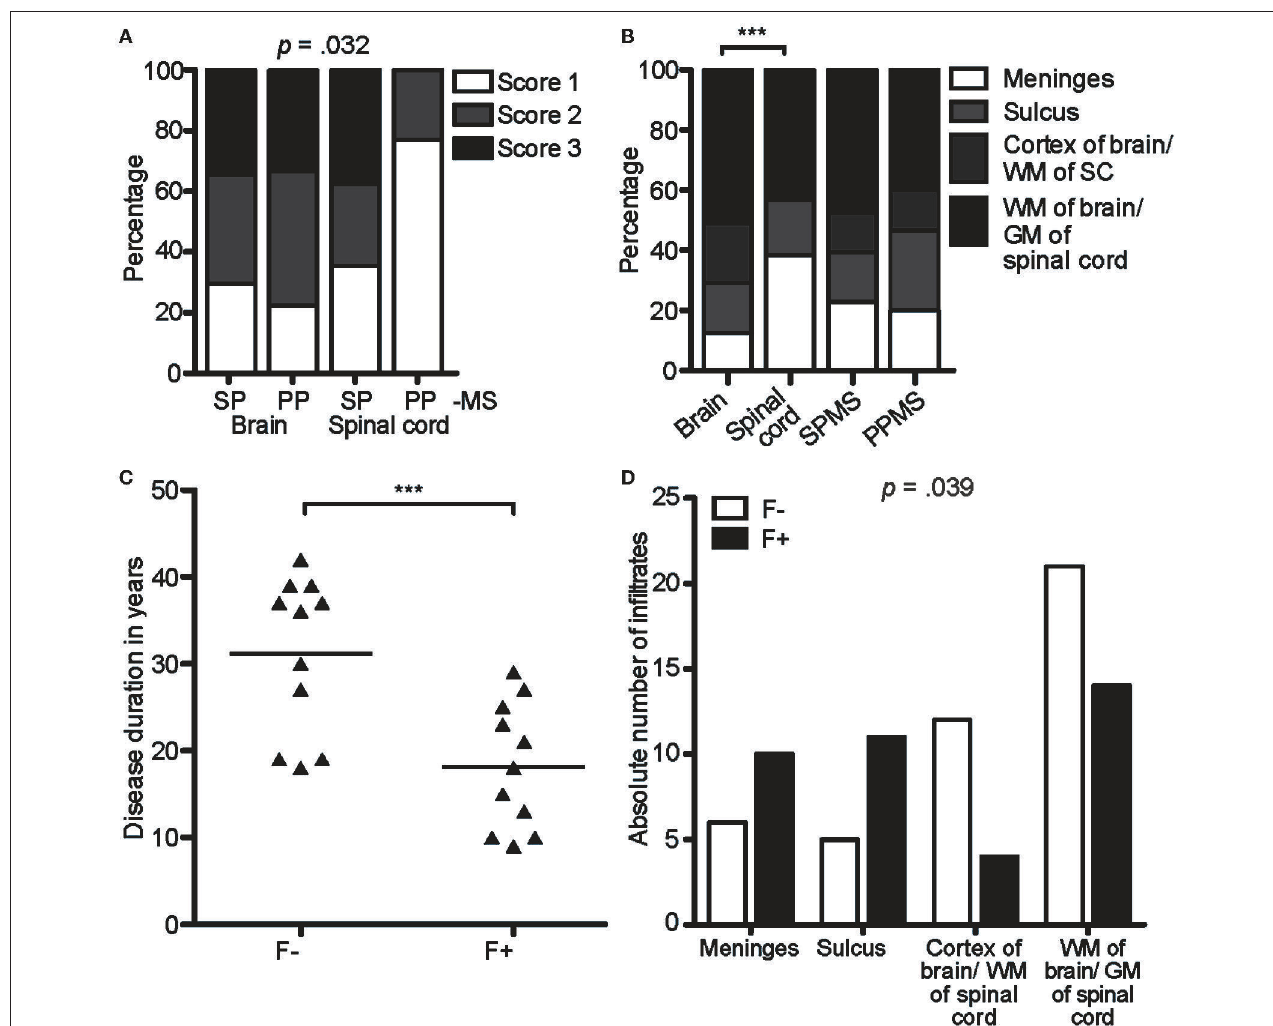
FIGURE 2 | CXCR5-rich lymphoid aggregates are most prominent within meninges of SPMS patients. (A) Percentage of score infiltration in SPMS and PPMS in CAL brain and spinal cord. SPMS brain infiltrates, n = 78; SPMS spinal cord, n = 48; PPMS brain, n = 9; PPMS spinal cord, n = 13. Chi-square test, X 2 (6) = 13.77, p = 0.032, d = 0.641. (B) Percentage of regional infiltration in meninges, sulcus, cortex of the brain/WM of the spinal cord and parenchyma of the brain/GM of the spinal cord in CAL SPMS and PPMS. SPMS, n = 145; PPMS, n = 15; brain, n = 96; spinal cord, n = 64. Chi-square test for SPMS vs. PPMS, X 2 (6) = 1.02, p = 0.799, d = 0.168; Chi-square test for brain vs. spinal cord, X 2 (3) = 21.19, p < 0.001, d = 0.793. (C) Disease duration in years in follicle-like structures (F + ) vs. other infiltrates (F-) in SPMS. F-, M = 31.18, SD = 9.05, n = 11; F + , M = 18.18, SD = 7.26, n = 11; unpaired t -test, t (20) = 3.72, p = 0.001. (D) Absolute number of infiltrates